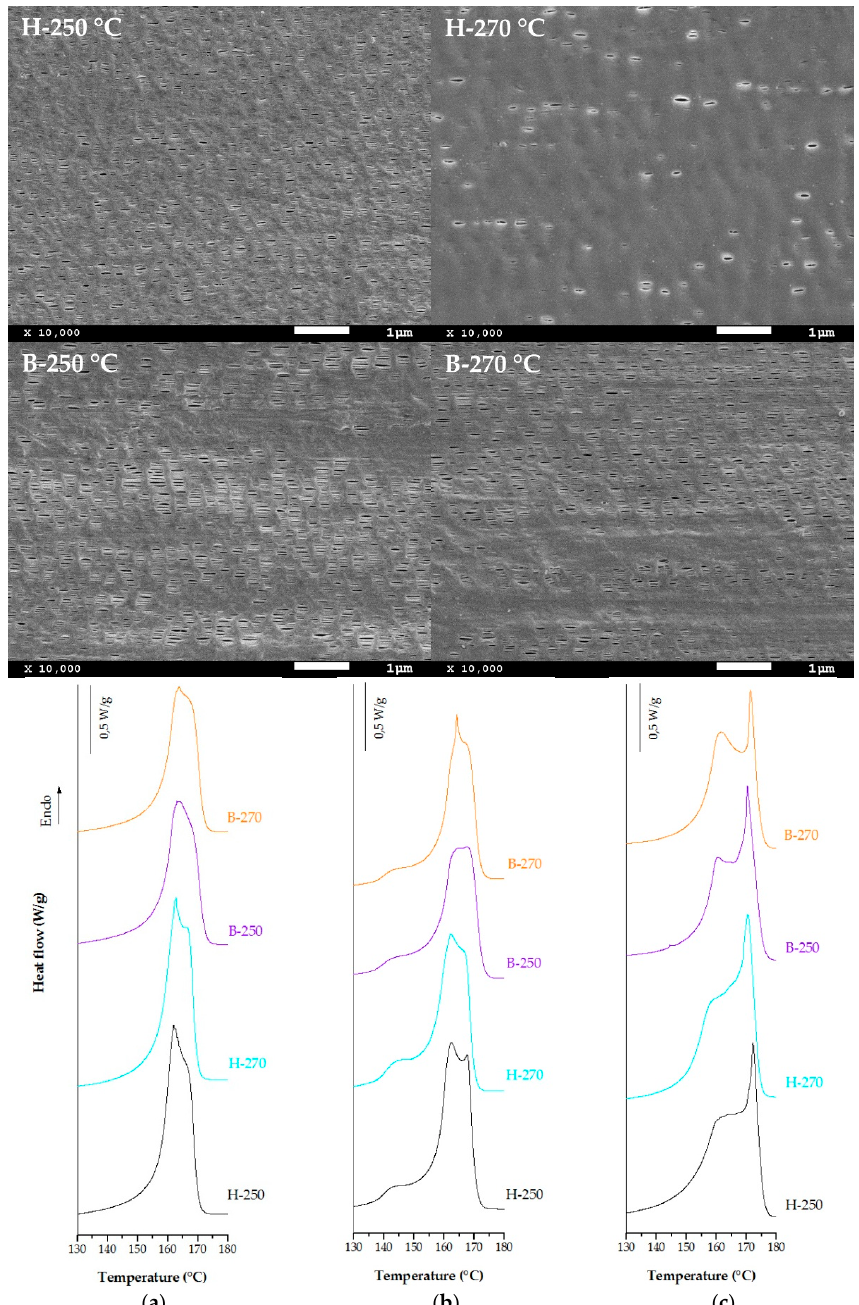
Figure 2. Scanning electron microscopy (SEM) micrographs and differential scanning calorimetry (DSC) thermograms of samples H and B extruded at different temperatures (250 and 270 ◦ C), ( a ) precursor films, ( b ) annealed precursor films at 140 ◦ C, ( c )